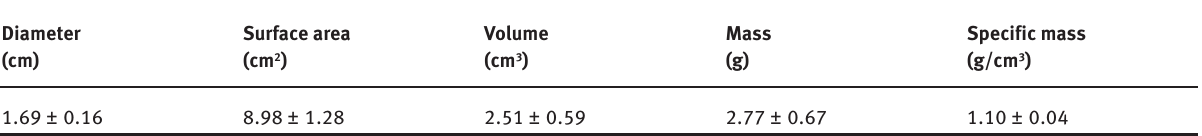
Table 1: Biometric characteristics of physalis